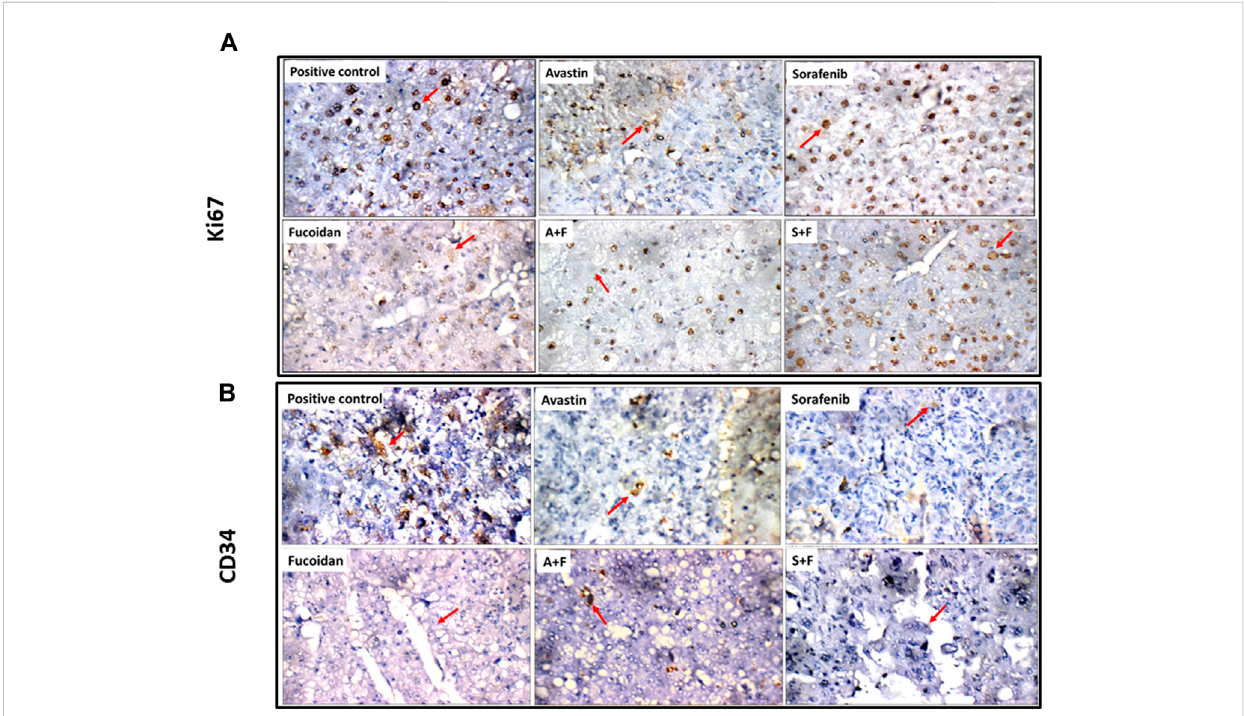
FIGURE 14 (A) Photomicrographs showing immunohistochemical staining for Ki67intumornodules(redarrows)within liver tissues extracted from ratstreated with the different drugs. Ki67 positivity was evaluated according to percentage of positive cells into four degree: (-) < 24%, (+) 25% – 50% (Isolated), (++) 51% – 74% (Focal), (+++) > 75% (Diffuse) (Mocanu et al., 2012). Positive control showing focal reactivity (++), Avastin showing negative reactivity (-), Sorafenibshowingisolatedreactivity(+)whilefucoidanshowingnegativereactivity(-)forKi67.A+Fshowingnegativereactivity(-)forKi67andS+F showing isolated reactivity (+) (Ki67 immunostaining (red arrows), x 400). (B) Photomicrographs showing immunohistochemical staining for CD34 in endothelial cells in tumor nodules (red arrows) within liver tissues extracted from rats treated with the different drugs. The number of positive cells for CD34 staining was evaluated as follows: (0 = 0%, 1 = 1 – 25%, 2 = 26 – 50%, 3 = 51 – 75%, and 4 = 76 – 100% of cells) as described by (Kamat et al., 2006). Positive control showing moderate reactivity (2) for CD34 in tumor nodules. Avastin and sorafenib showing weak reactivity (1) while fucoidan showing negative reactivity (0) for CD34 in tumor nodules. A + F showing weak reactivity (+) while S + F showing negative reactivity (0) for CD34 in tumor nodules (red arrow) (CD34 immunostaining (red arrows), x